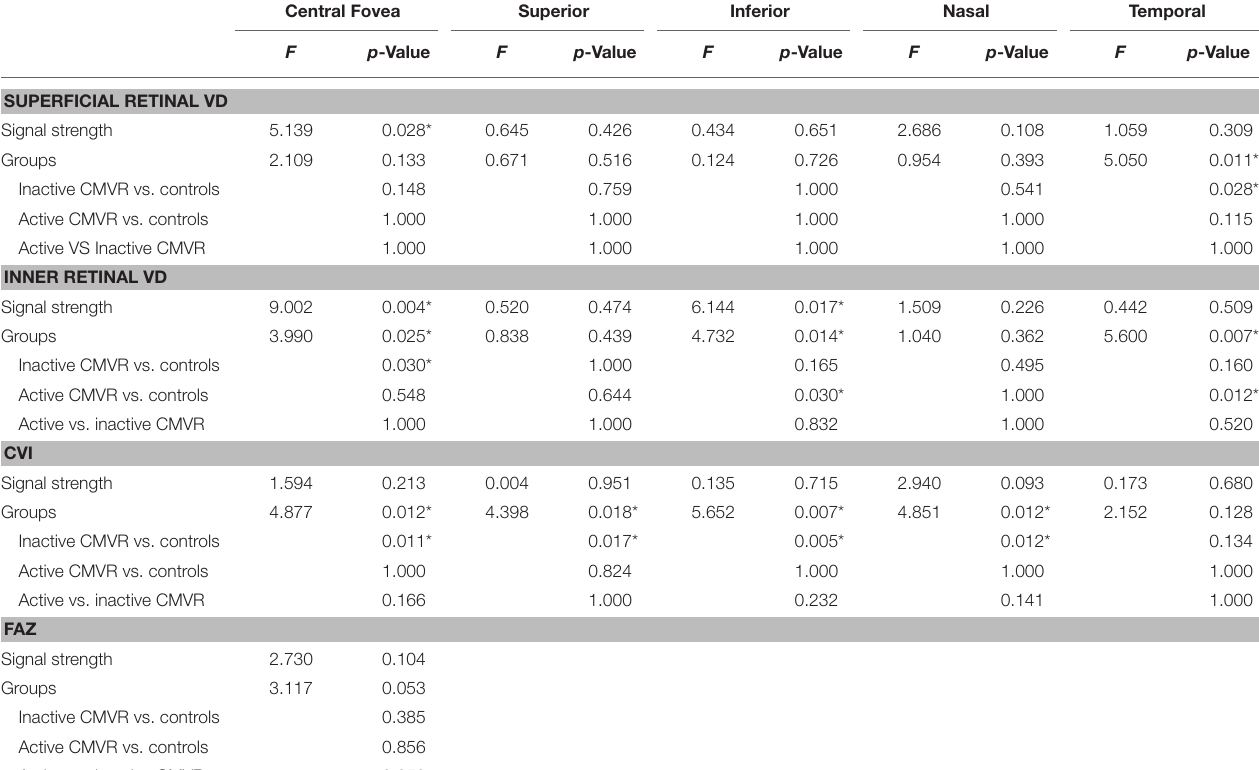
TABLE 2 | Statistical results of OCTA parameters of macular microvasculature for all groups. Central Fovea Superior Inferior